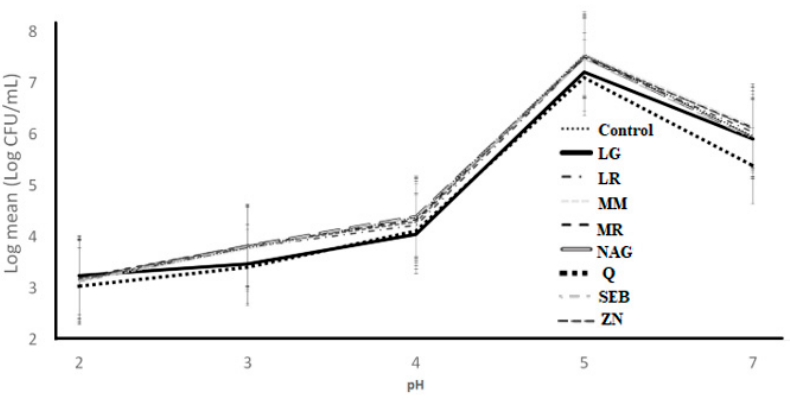
Figure 8. Log counts of Lactobacillus bulgaricus showing its resistance to simulated gastric juice as influenced by ingredients over different pH conditions. C = control, LG = L-glutamine (7 g/L), Q = quercetin (700 mg/L), SEB = slippery elm bark (210 mg/L), MR = marshmallow root (1340 mg/L), NAG = N-acetyl-D-glucosamine (210 mg/L), LR = licorice root (210 mg/L), MM = maitake mushrooms (42 mg/L), and ZN = zinc orotate (70 mg/L). Error bars represent SE.